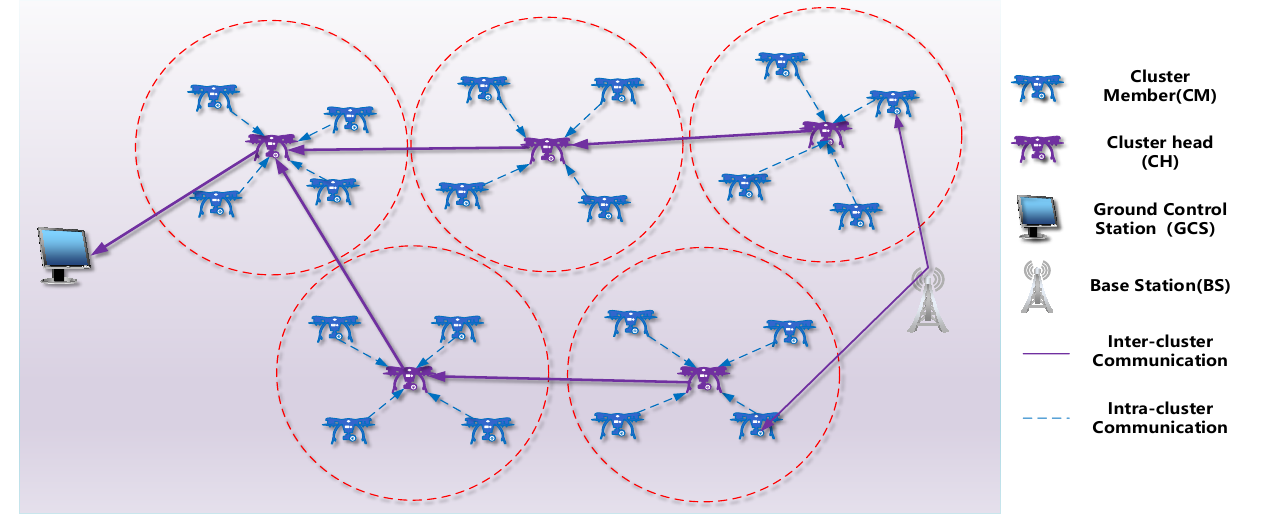
Figure 1. UAV clustering network structure.